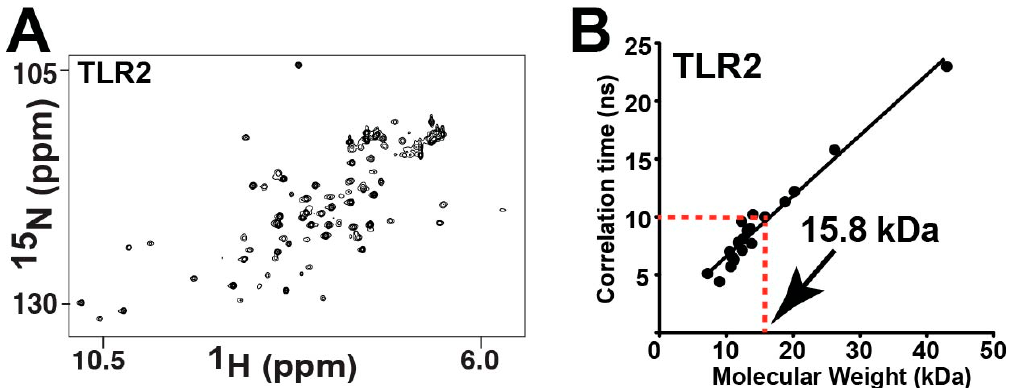
Figure 7. Chemical exchange within TLR2-TIR leads to the loss of numerous resonances. ( A ) 15 N- HSQC of 460 μ M TLR2-TIR. ( B ) A correlation time of 22 ± 1.5 ns for TLR2-TIR was determined from the ratio of 51 R2/R1 relaxation rates and a molecular weight of 15.8 kDa estimated based on a comparison to previously measured correlation times [45]. It was immediately obvious that the TLR2-TIR domain also undergoes exchange, as less than half of the expected resonances are observed within its 15 N-HSQC spectrum (Fig- ure 7A). As opposed to the TLR1-TIR C707A mutation, which induced only minor changes to its spectrum (Figure S4A), the TLR2-TIR C713A mutation led to the emergence of many new resonances (Figure S4B). This indicates that there is a global dynamic coupling in TLR2-TIR to this site and its mutation likely shifts an equilibrium that leads to slightly less line-broadening. Unfortunately, only marginal differences are observed to the spectrum upon increasing the temperature (Figure S4C) or through the use of TROSY-based meth- ods (Figure S4D). In order to determine whether the lack of resonances of TLR2-TIR is an inherent dynamic of the monomer or due to chemical exchange mediated by self-associa- tion, we first utilized NMR relaxation to estimate the correlation time of TLR2-TIR (Table S2). By measuring R2 and R1 relaxation rates, the average R2/R1 ratio was determined to be 22.18, which was then used to calculate a correlation time of 10.2 ns using the previ- ously described equation [46]. This correlation time can then be used to estimate the mo- lecular weight using protein standards, as we have previously described [45]. Using this correlation time for TLR2-TIR and a plot of protein standards (Figure 7B), the associated molecular weight was estimated at 15.8 kDa, which is slightly less than the calculated molecular weight based on the sequence of 18.2 kDa. Thus, our data suggests that TLR2-